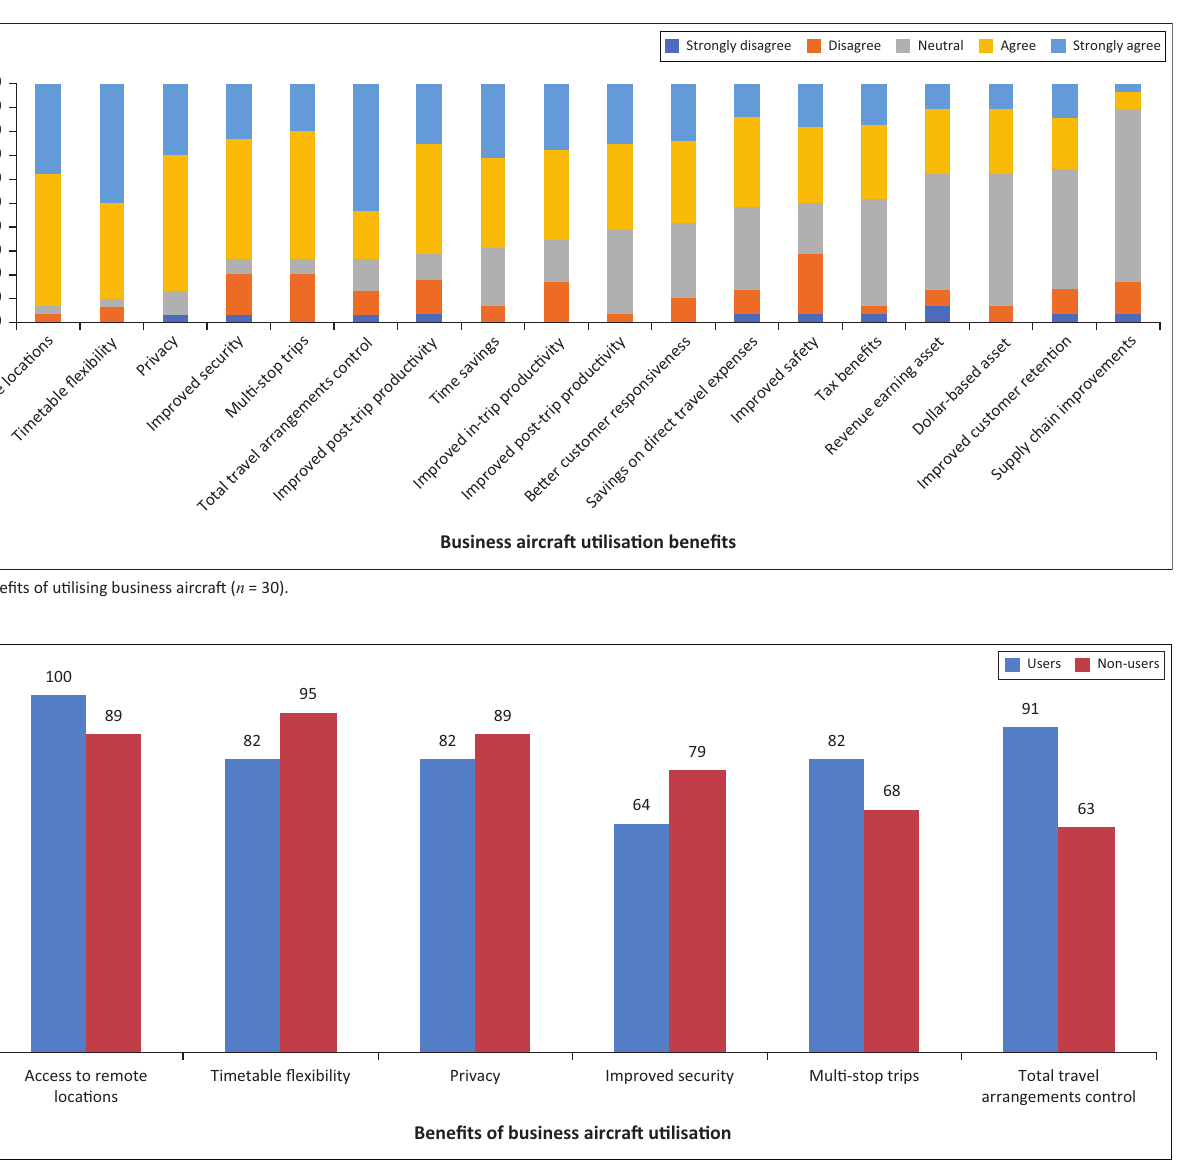
FIGURE 3: Comparison of business aircraft users and non-users regarding benefits of utilisation ( n = 11 users and n = 19